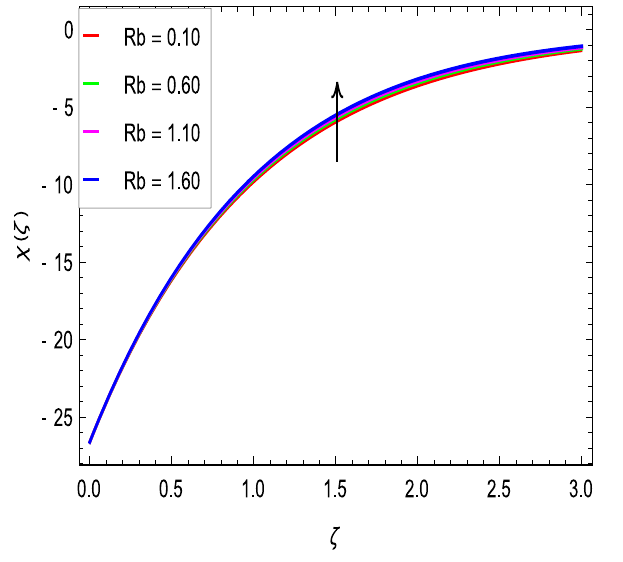
Figure 22. χ(ζ) in terms of Rb .